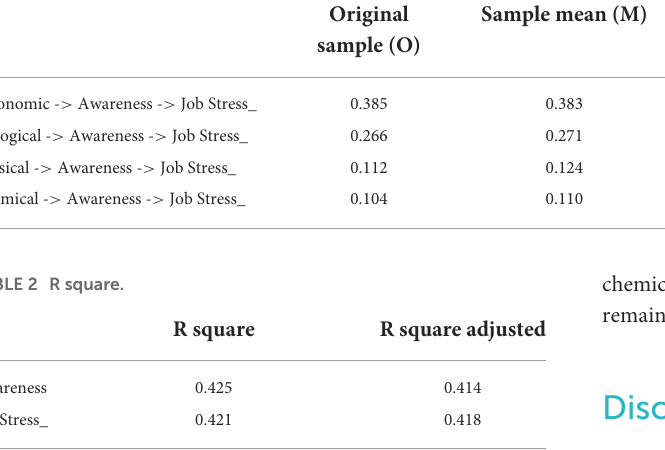
TABLE 4 Specific indirect effect.